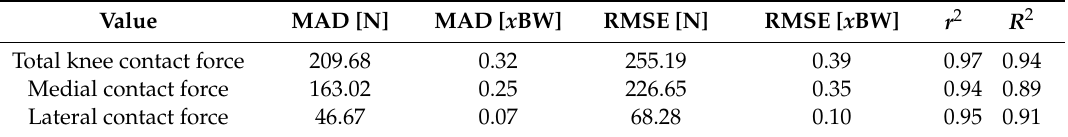
( D ) tibiofemoral contact forces (in unit of body weight BW) of the in vivo measurements (blue, [57]) to our predictions (red). Table 1. Kinetic validation of the tibiofemoral joint. Quantitative analysis of the predicted medial, lateral, and total tibiofemoral contact forces with reference to in vivo measurements during the two-leg squat motion cycle as reported by Fregly et al. [57]. Units are expressed in Newton (N) and body weight ( x BW). Mean absolute deviation (MAD), root-mean-square error (RMSE), Pearson correlation coe ffi cient ( r 2 ), and coe ffi cient of determination ( R 2 ).